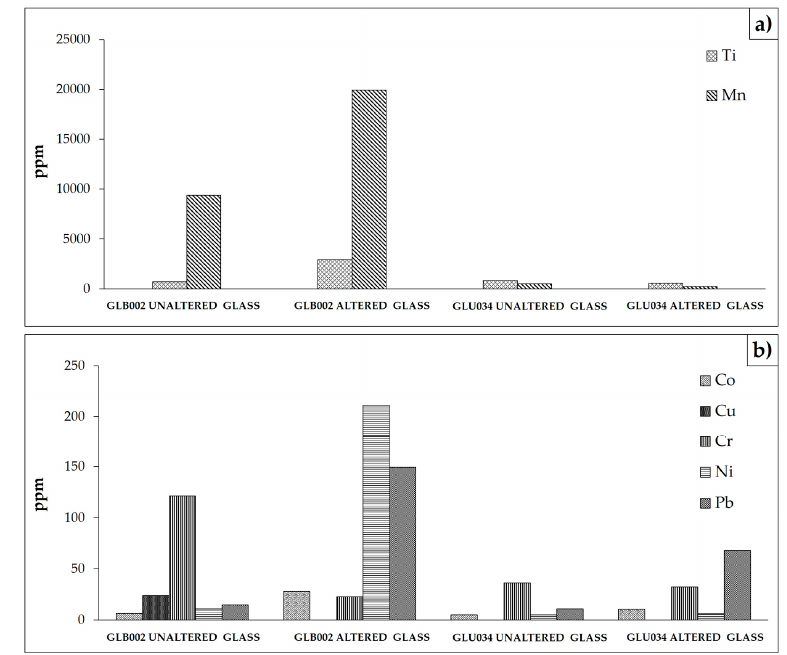
Figure 14. Histograms of ( a ) Mn, Ti; ( b ) Co, Cr, Cu, Ni, Pb in both unaltered and altered areas of GLB002 and GLU034 samples.